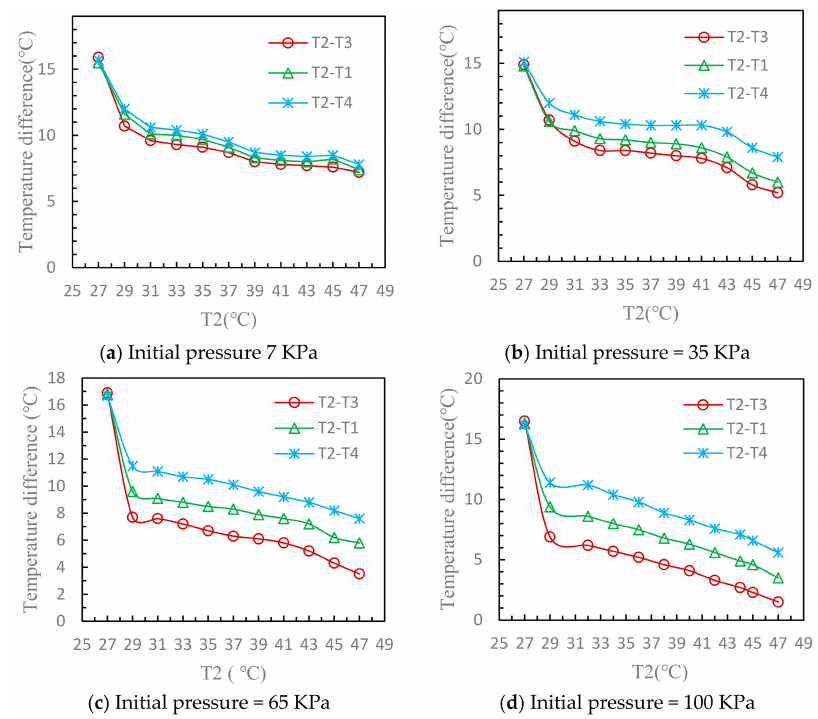
Figure 5. Variation in temperature difference during drying under different initial